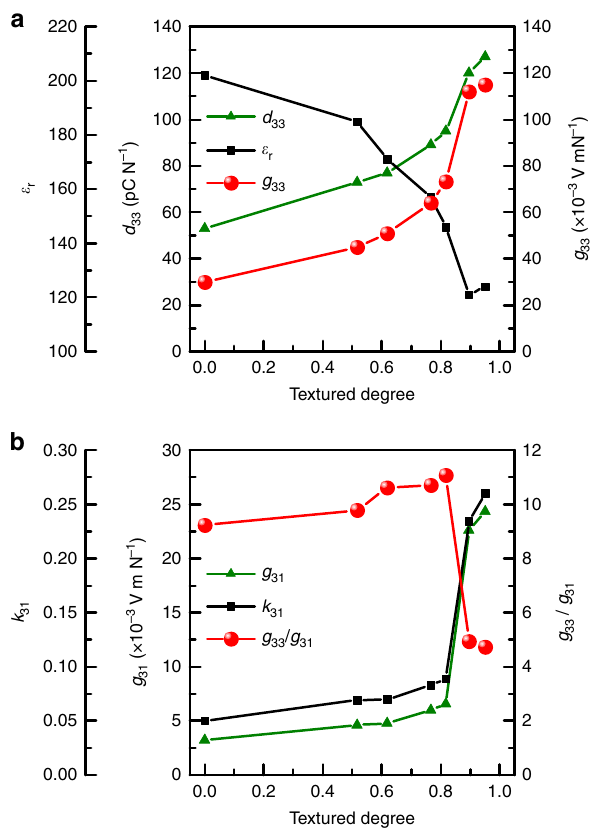
Figure 4 | Piezoelectric properties of doped PTceramics as a function of texture degree. ( a ) e r , d 33 and g 33 and ( b ) k 31 , g 31 and g 33/ g 31 . NATURE COMMUNICATIONS|7:13089|DOI: